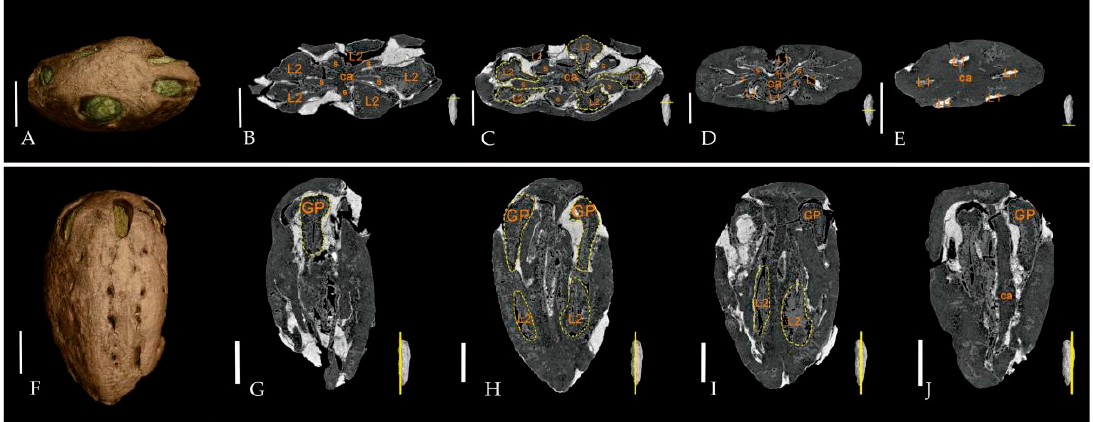
Figure 4. Characteristics of endocarps of Choerospondias tiantaiensis under micro-CT. (( A – J ), JHU3-16-059) ( A , F ): micro-CT volume renderings. ( B – E , G – J ): micro-CT orthoslices of endocarp showing the internal structures. s = septa; ca = central axis; L1 = lacunae; L2 = locules; GP = germination pore. ( B – E ): Transverse sections of fossil endocarp from the top to the base, showing the arrangement of locules (yellow-dotted lines) and lacunae through the long axis of the endocarp. ( G – J ): Longitudinal sections of fossil endocarp showing the arrangement of locules (yellow-dotted lines) and germination pores. ( A – E ), scale bar = 2 mm; ( G – J ), scale bar = 3.5 mm. Diagnosis: The endocarps were ovoid to oval with obscure ridges on their surface and some irregularly arranged pits. Five germination pores were observed distributed radially near the top. Five pits radially situated around the subacute base of the outer endocarp were also observed. The endocarp wall was composed of irregularly arranged fibers and smaller oval-shaped isodiametric sclereids. A clear boundary existed between the nexine and endothecium of the endocarp.